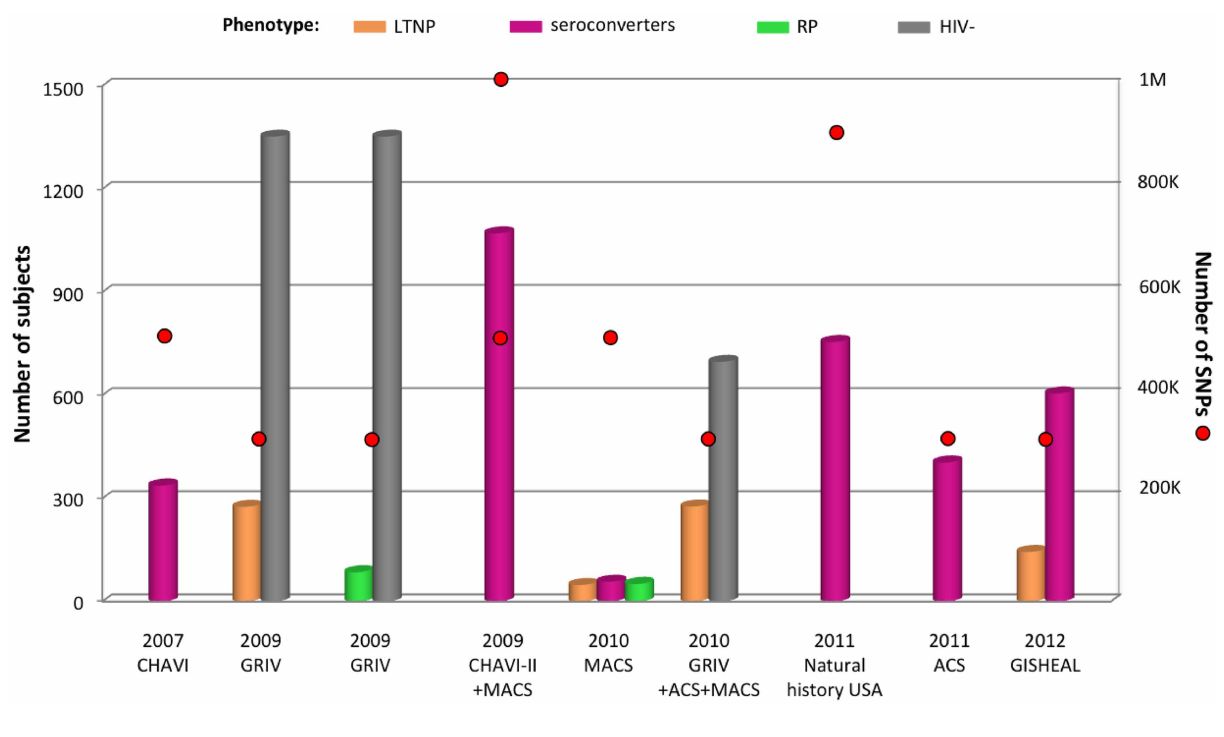
FIGURE 3 | Summary of GWAS design focusing on disease progression .The histogram presents the number of subjects and red circles display the number of SNPs covered by the genotyping arrays.Two red circles are symbolized for one cohort when individuals were genotyped using two sets of arrays. All subjects are from European